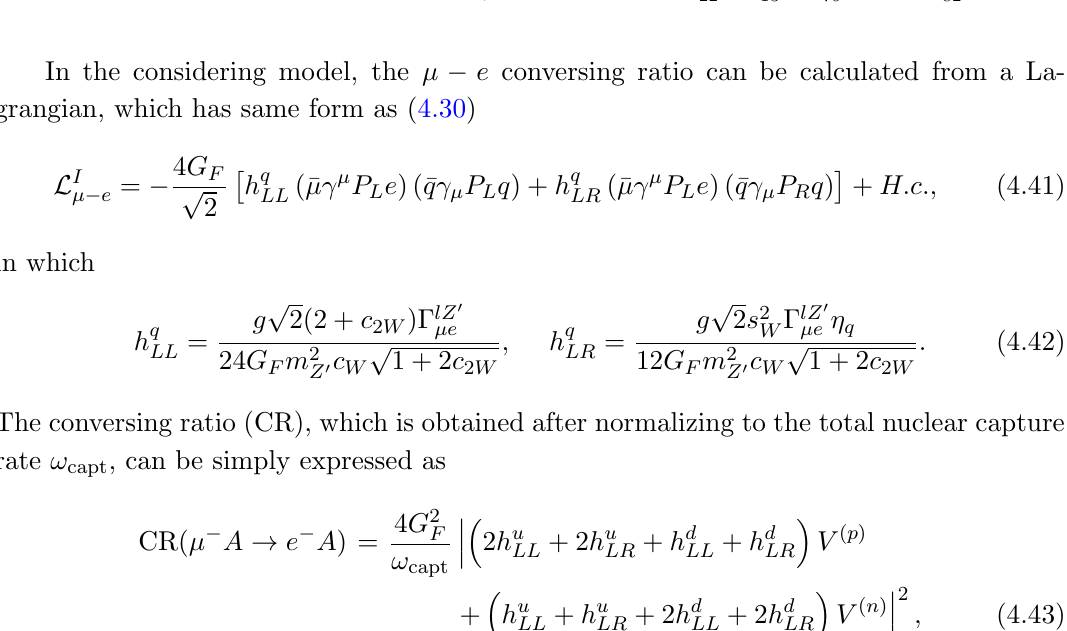
Ti, 27 Al, 197 Au and 208 Pb. 22 13 79 82